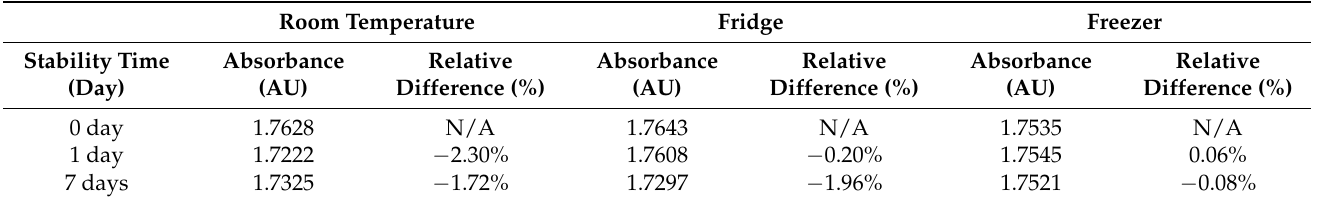
Table 9. Stability of the standard solution 60 µ g/mL stored at three different temperatures: room temperature, fridge, and freezer, as analyzed by absorption spectroscopy (spectrophotometry).